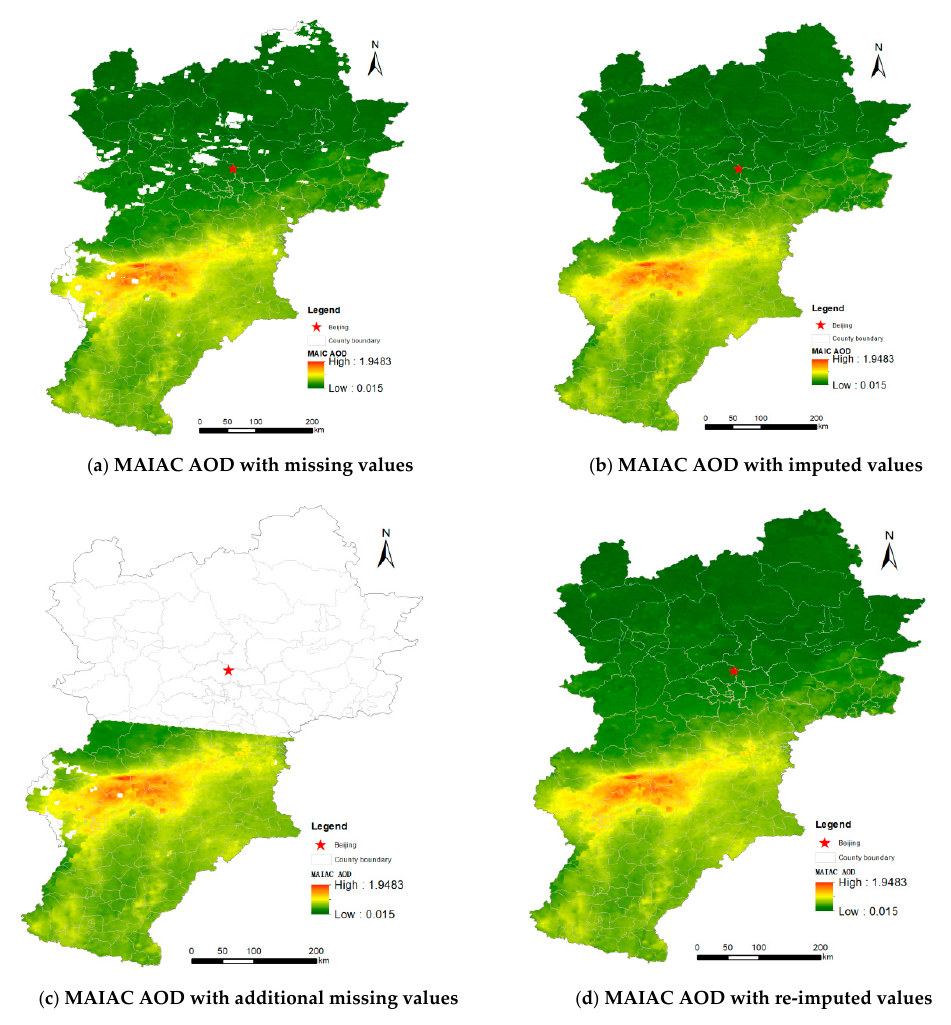
Figure 6. Original ( a ) and imputed MAIAC AOD ( b ), MAIAC AOD with additional missing values ( c ) and MAIAC AOD of re-imputed values ( d ) for a spring day (20 April